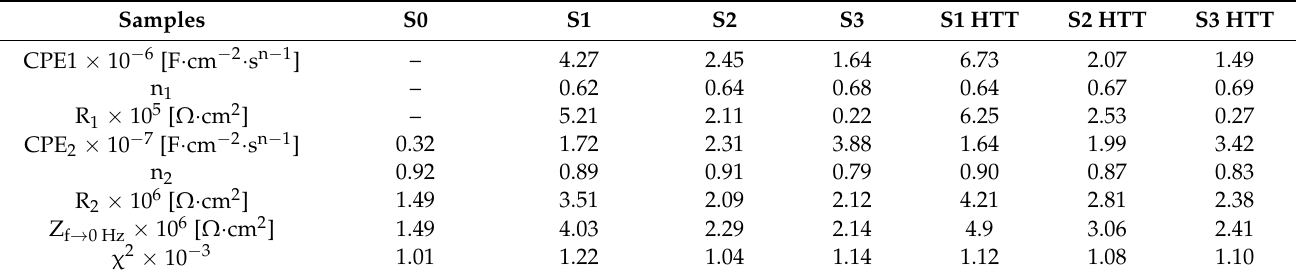
Figure 10. The Nyquist and Bode plots for the S0 and S1–S3 samples obtained in Hanks’ solution: ( a ) Curves for the full frequency range of the impedance; ( b ) low-frequency impedance curves; ( c ) Bode-phase plots; ( d ) Bode impedance plots. Symbols refer to experimental values, and solid lines refer to fitted data. Table 7. The electrical parameters used for fitting the EIS data in Hanks’